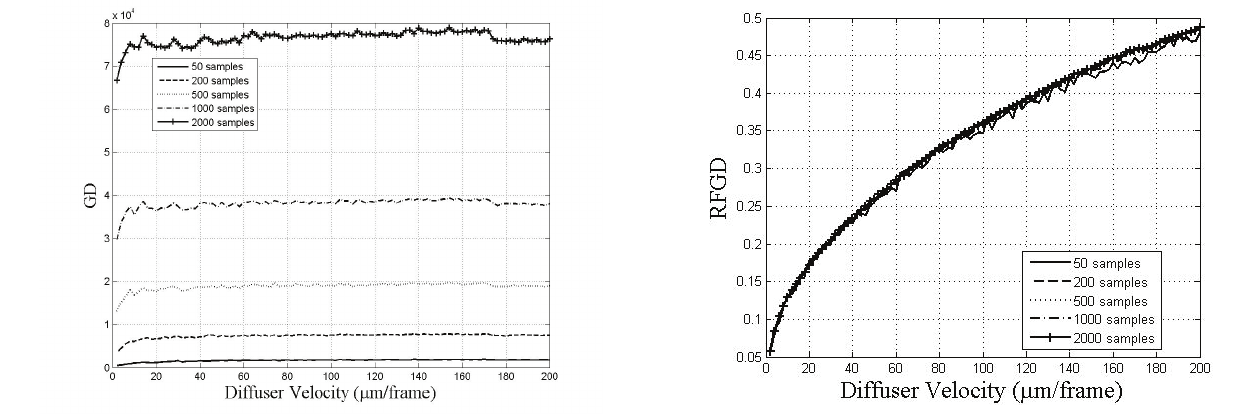
Fig. 15: Rough Fuzzy Granular descriptor ( RFGD